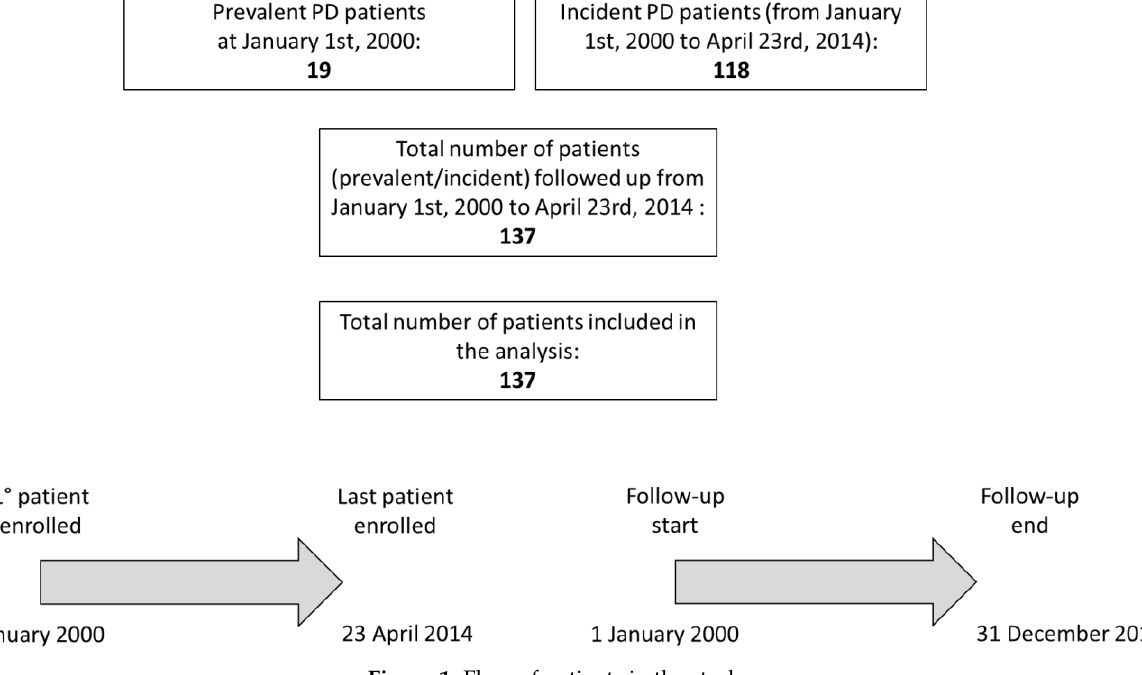
Figure 1. Flow of patients in the study.